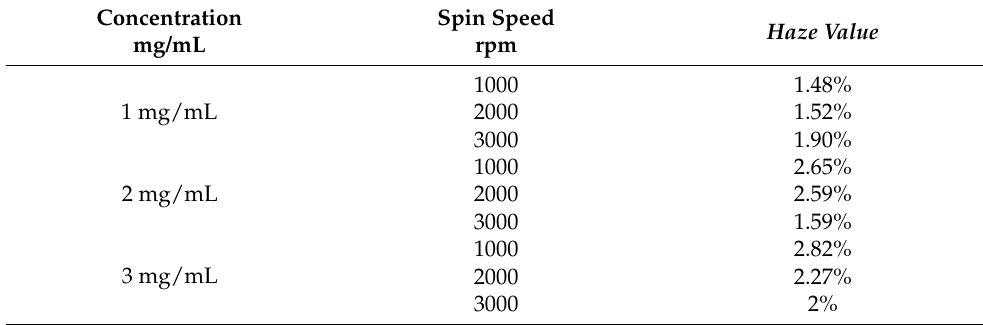
Table 5. The haze value of the AgNW transparent electrode at different concentrations and spin